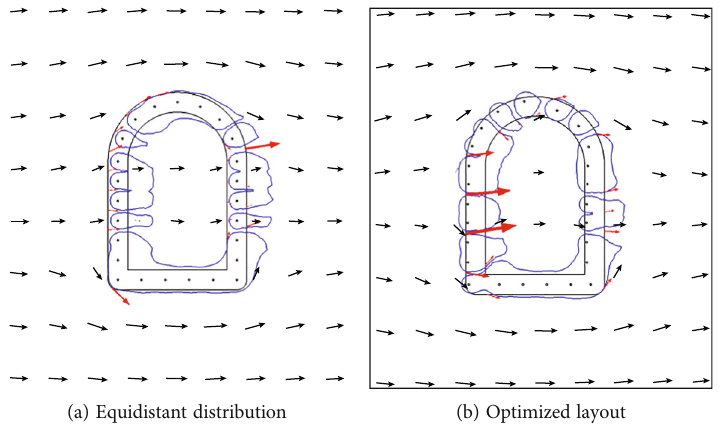
Figure 8: Frozen wall and seepage fl ow at freezing duration of 40 d.